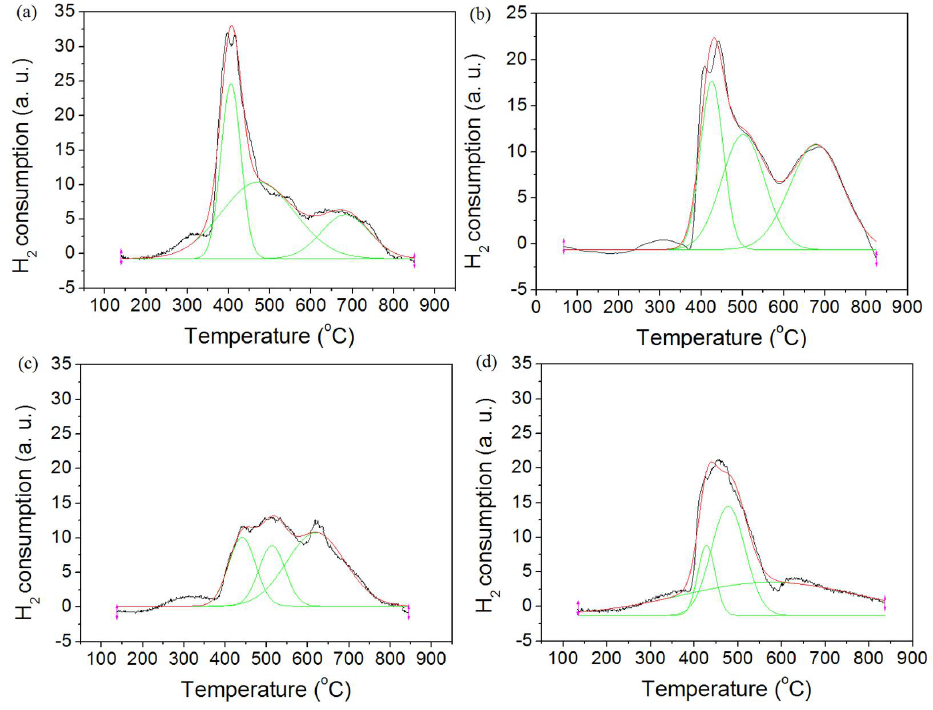
Figure 6. TPR profiles of different catalysts: ( a ) NTS; ( b ) NCTS(co); ( c ) NCTS(ad) and ( d ) NCTS(st).